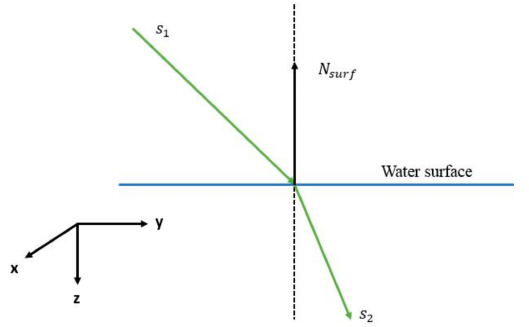
Figure 4. The directional vectors for the transmitted ray through the water surface, incident ray ( s 1 ), refracted ray ( s 2 ) and the water surface normal vector ( N surf ). The axis conventions are also